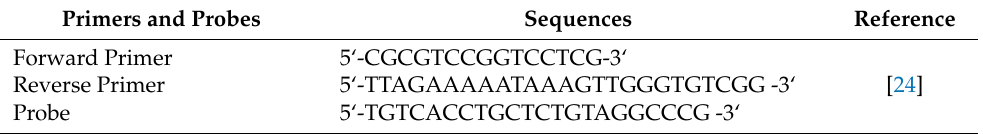
Table 2. Sequence of primers and TaqMan probes used for real-time PCR of Aspergillus section Fumigati . Primers and